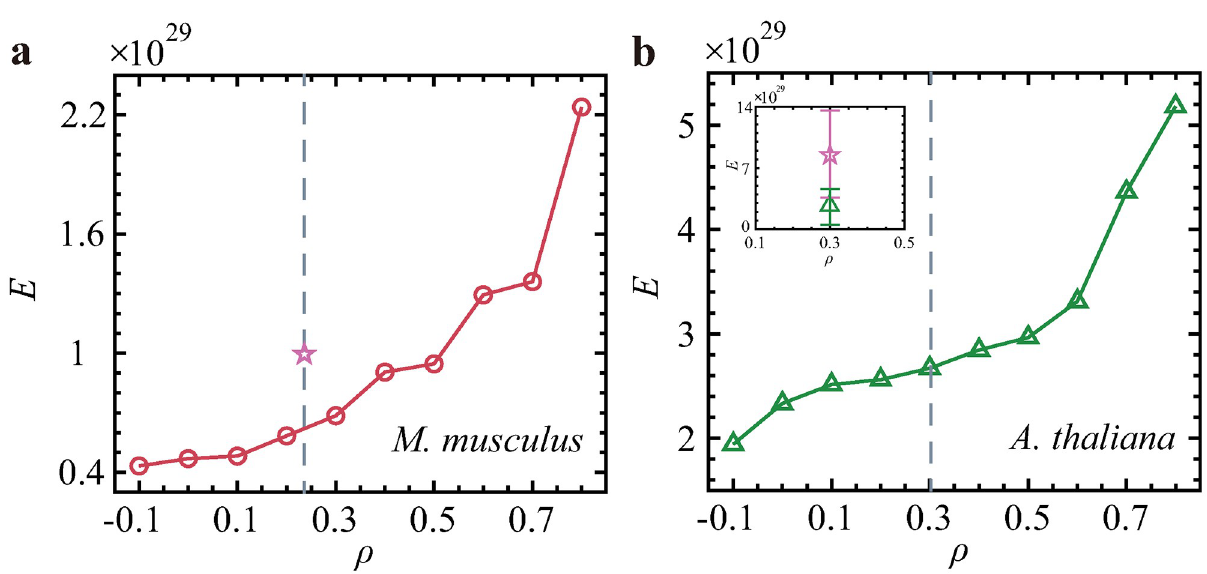
Fig 5. Control energy as functions of the degree-degree correlations between the layers of TRN-PPI multiplex networks. (a) M. musculus , and (b) ¼ ½ 1 ; 1 ; ... ; 1 � T . The numbers of driver nodes for the two eukaryotes are 570 A. thaliana . The initial state is x 0 = [0, 0, ��� , 0] T and the final state is x t f and 200, respectively. The gray dashed lines show the real values of the interlayer degree-degree correlations, and the purple pentagrams show the real values of n D for the real connections between layers. The purple and green solid lines in the inset are used to represent the errors between the real value of E and the corresponding 100 random realizations, respectively. Each data point is the mean of 100 independent realizations. https://doi.org/10.1371/journal.pone.0283768.g005 PLOS ONE | https://doi.org/10.1371/journal.pone.0283768 March 30,